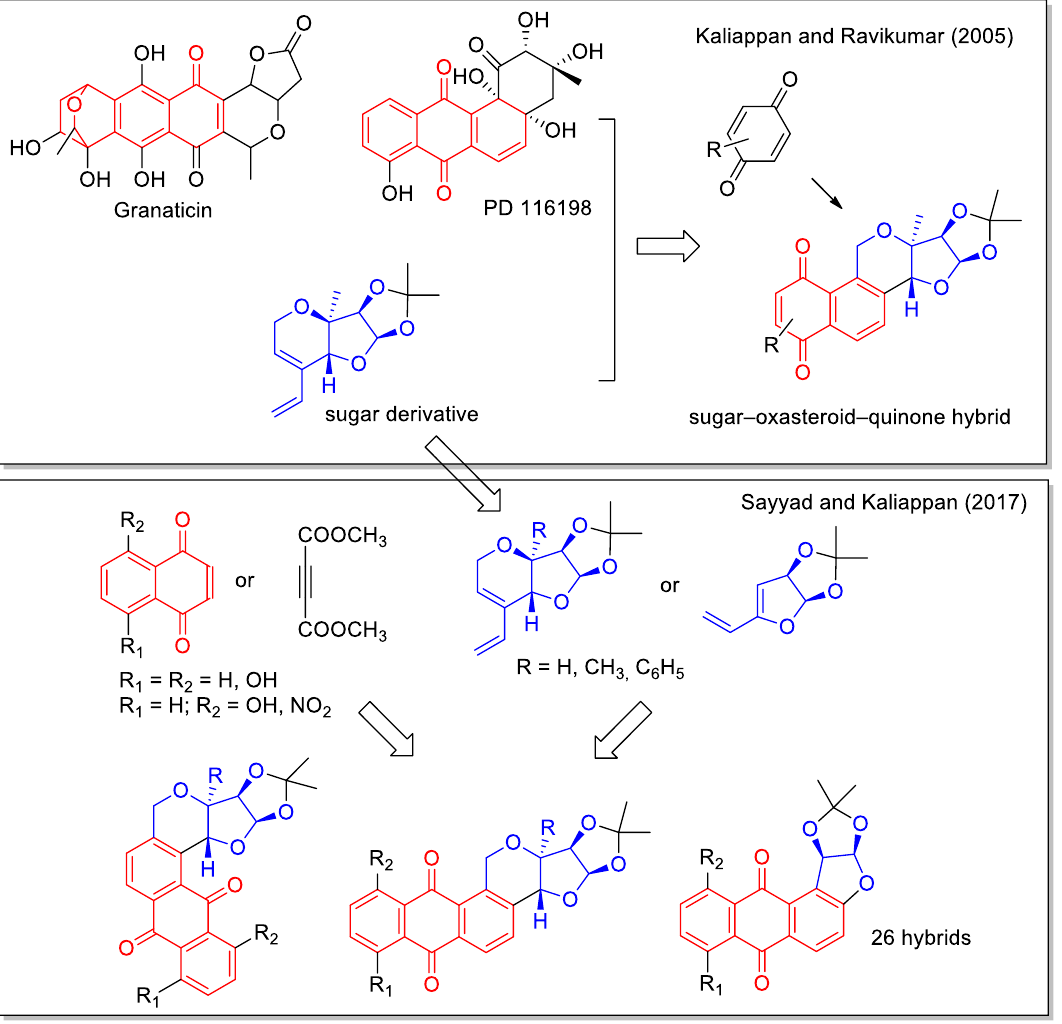
Figure 16. Sugar – oxasteroid – quinone hybrids as reported as reported by Kaliappan and coworkers Figure 16. Sugar–oxasteroid–quinone hybrids as reported as reported by Kaliappan and cowork- [49,50]. ers